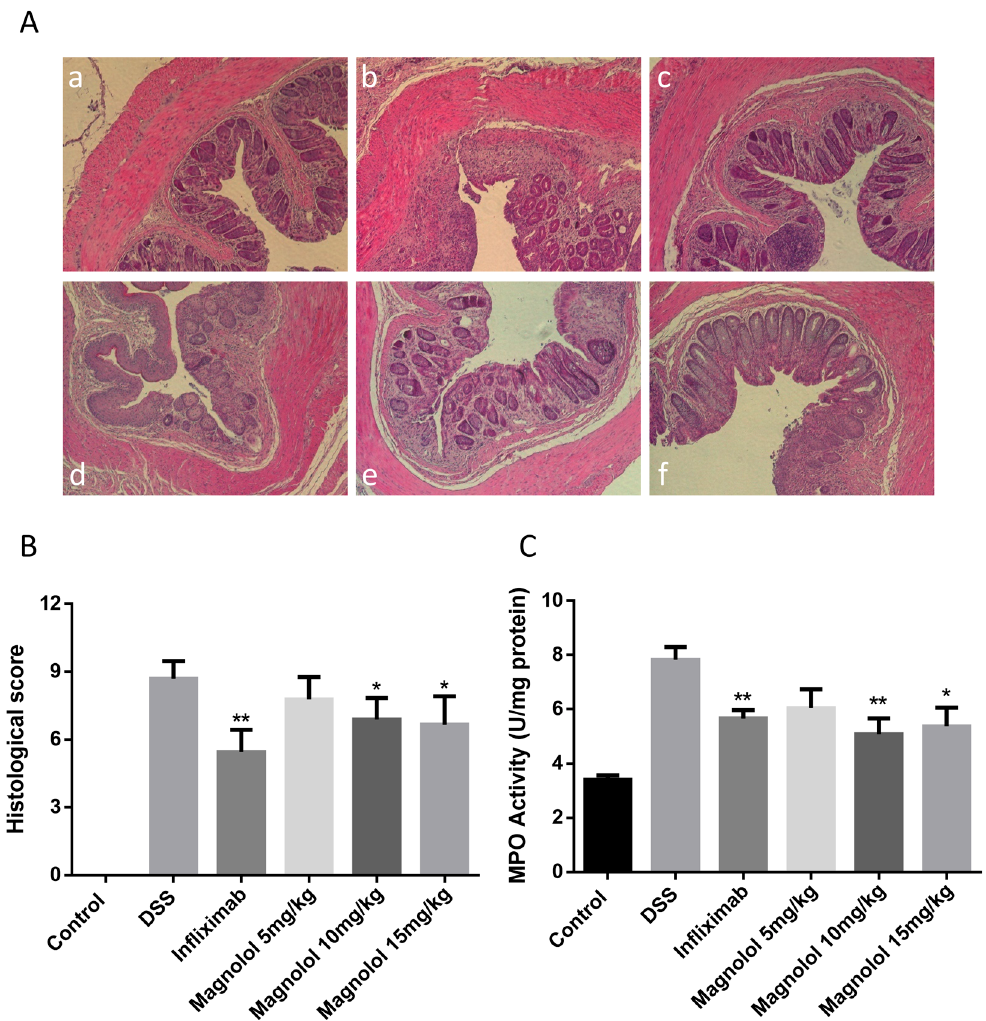
Figure 2. Medium and high dosages of magnolol effectively attenuated histopathological changes and myeloperoxidase activity in the colon of DSS-treated mice. ( A ) Representative images of hematoxylin/ eosin (H&E) staining (magnification, 10 × ): ( a ) Control group; ( b ) DSS group; ( c ) Infliximab group; ( d ) Magnolol 5 mg/kg; ( e ) Magnolol 10 mg/kg; ( f ) Magnolol 15 mg/kg; ( B ) Histological scores; ( C ) MPO activity. The value in the plot was expressed as means ± SEM, and statistically significant was marked by asterisk (* p < 0.05; ** p < 0.01).